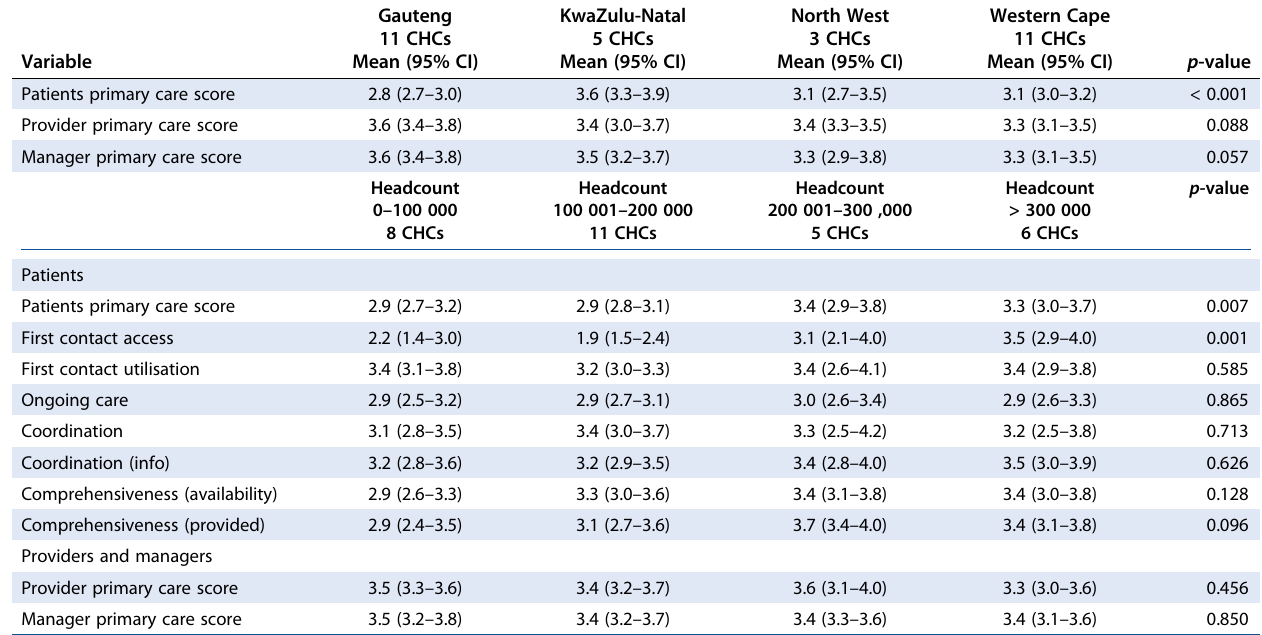
Table 4: Comparison of mean facility scores for provinces and headcounts by respondent categories